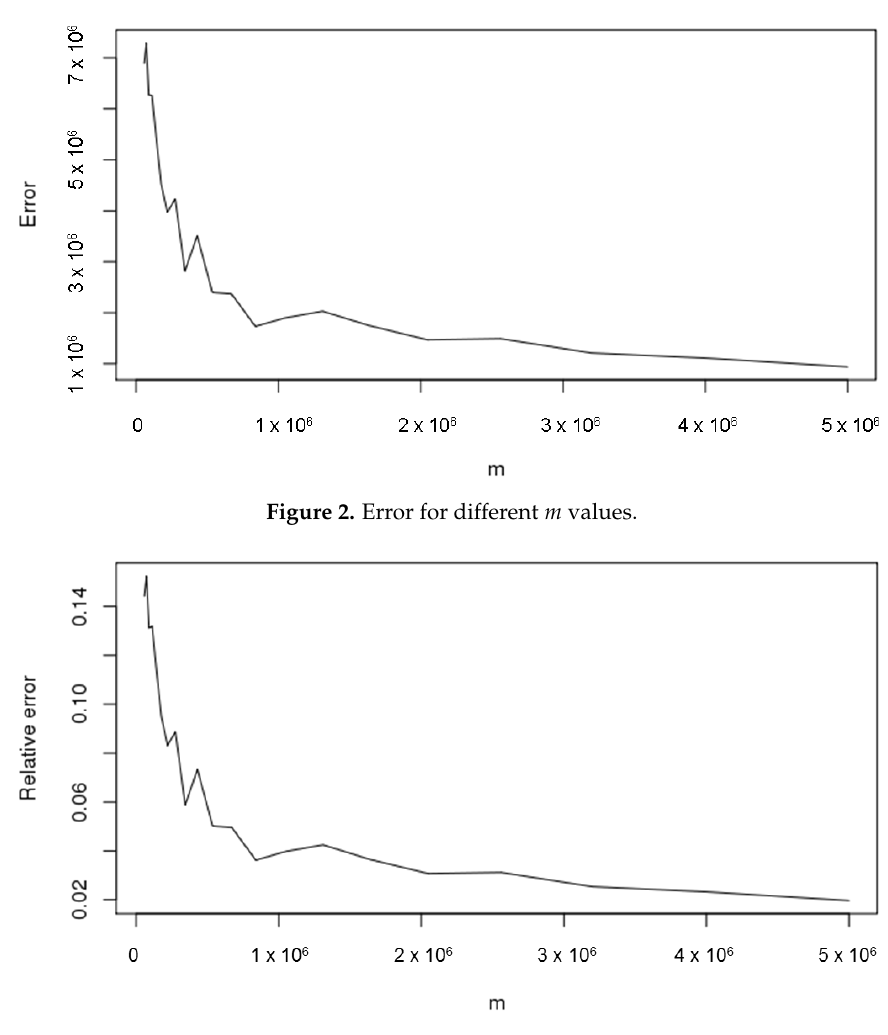
Figure 3. Relative error for different m